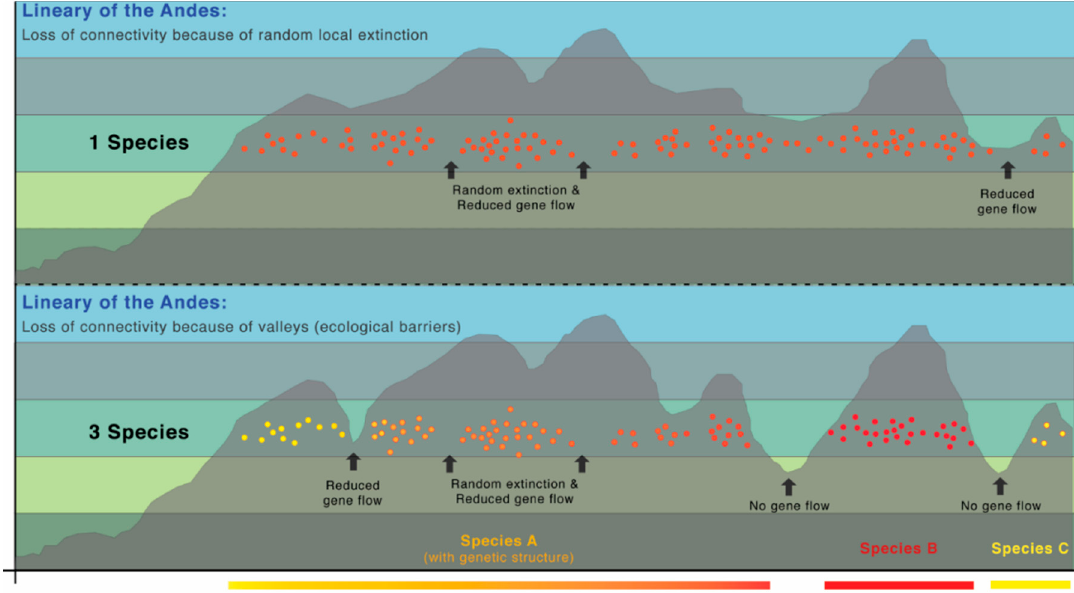
Figure 233. Speciation modes. Effect of the linearity of the Andes in diversification processes. Modified from Guayasamin et al. [194].